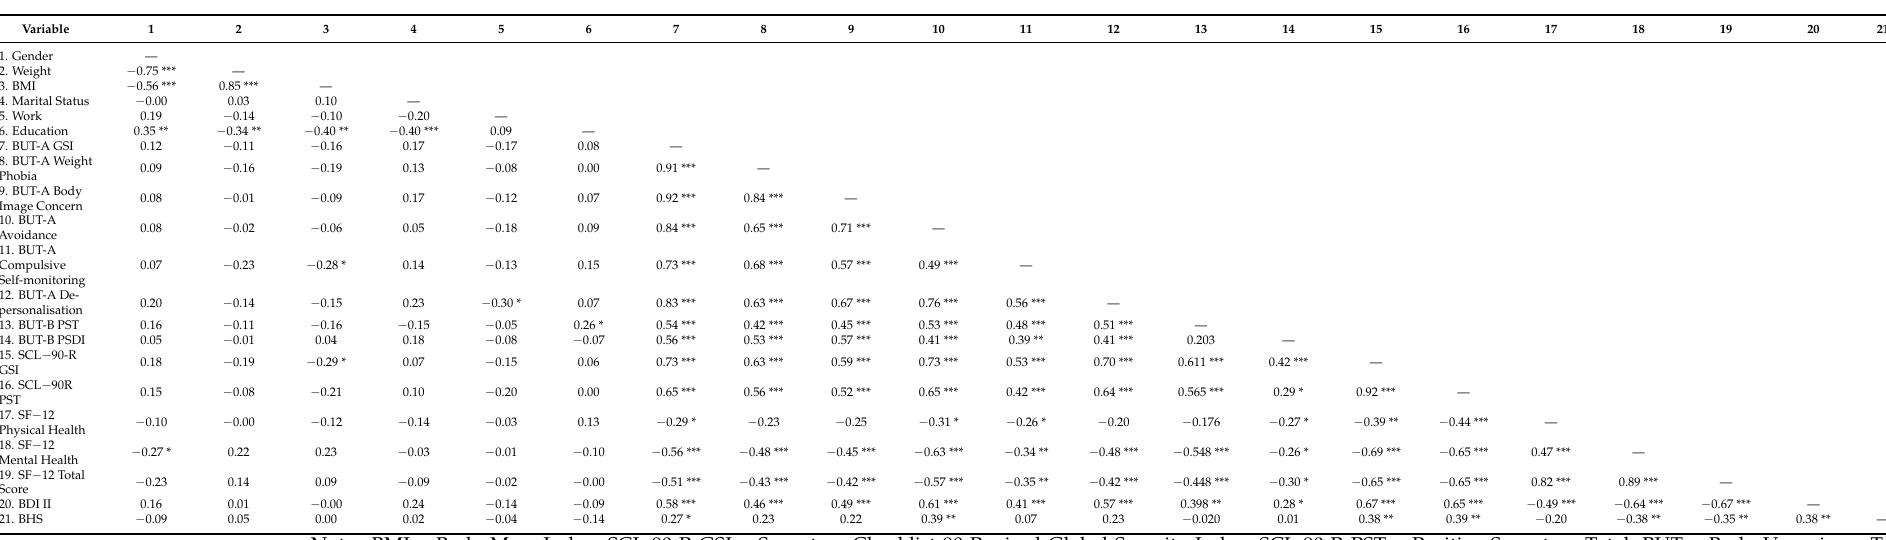
Table 2. Correlational analyses (Pearson’s r) among the weight, BMI, sociodemographic characteristics, BUT, SCL-90-R, SF-12, BDI II, and